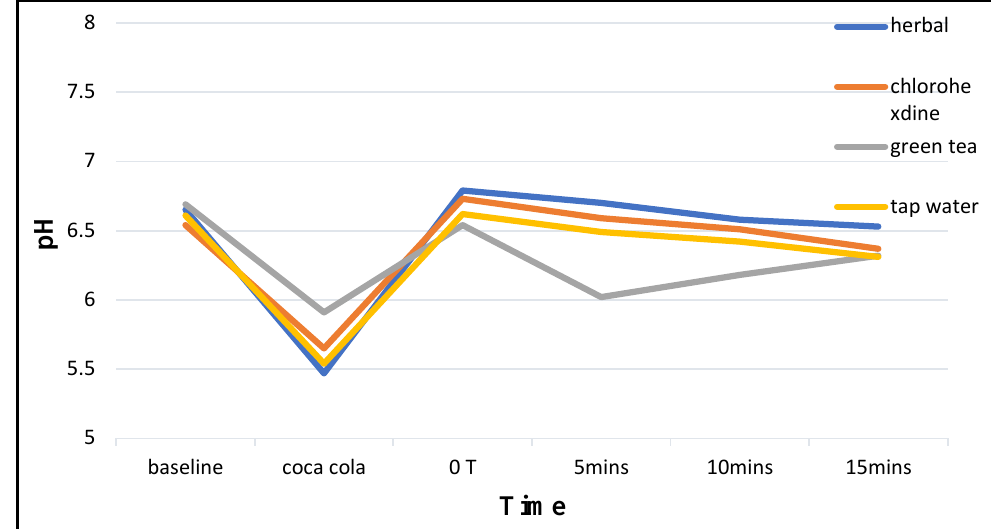
Figure 1 Durability of Salivary pH for different mouthwashes used in this